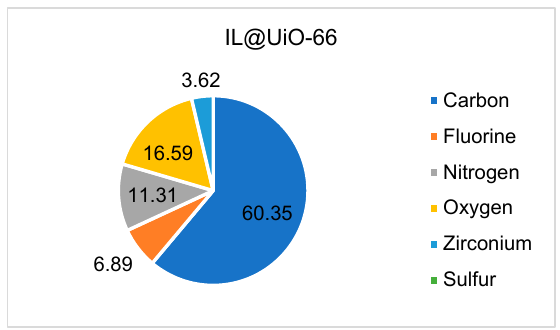
Figure 4. The atomic percentage of UiO-66 calculated from EDX.